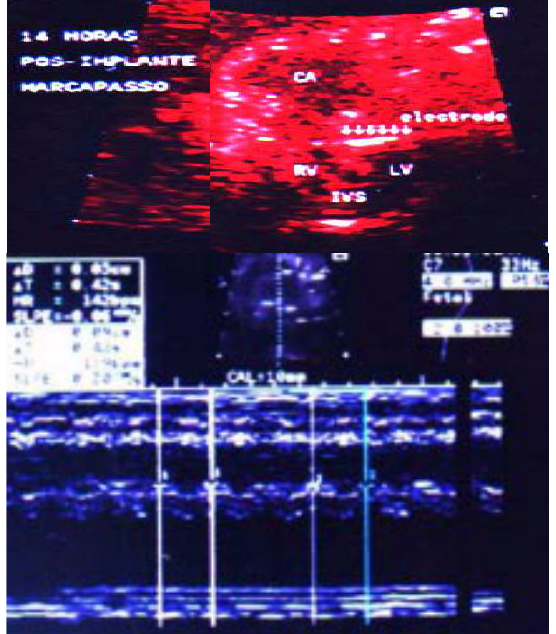
Fig. 2 - Echocardiogram (first postoperative day) revealed recovery of ventricular function, a stable fetal heart rate of 140 bpm and mild pericardial